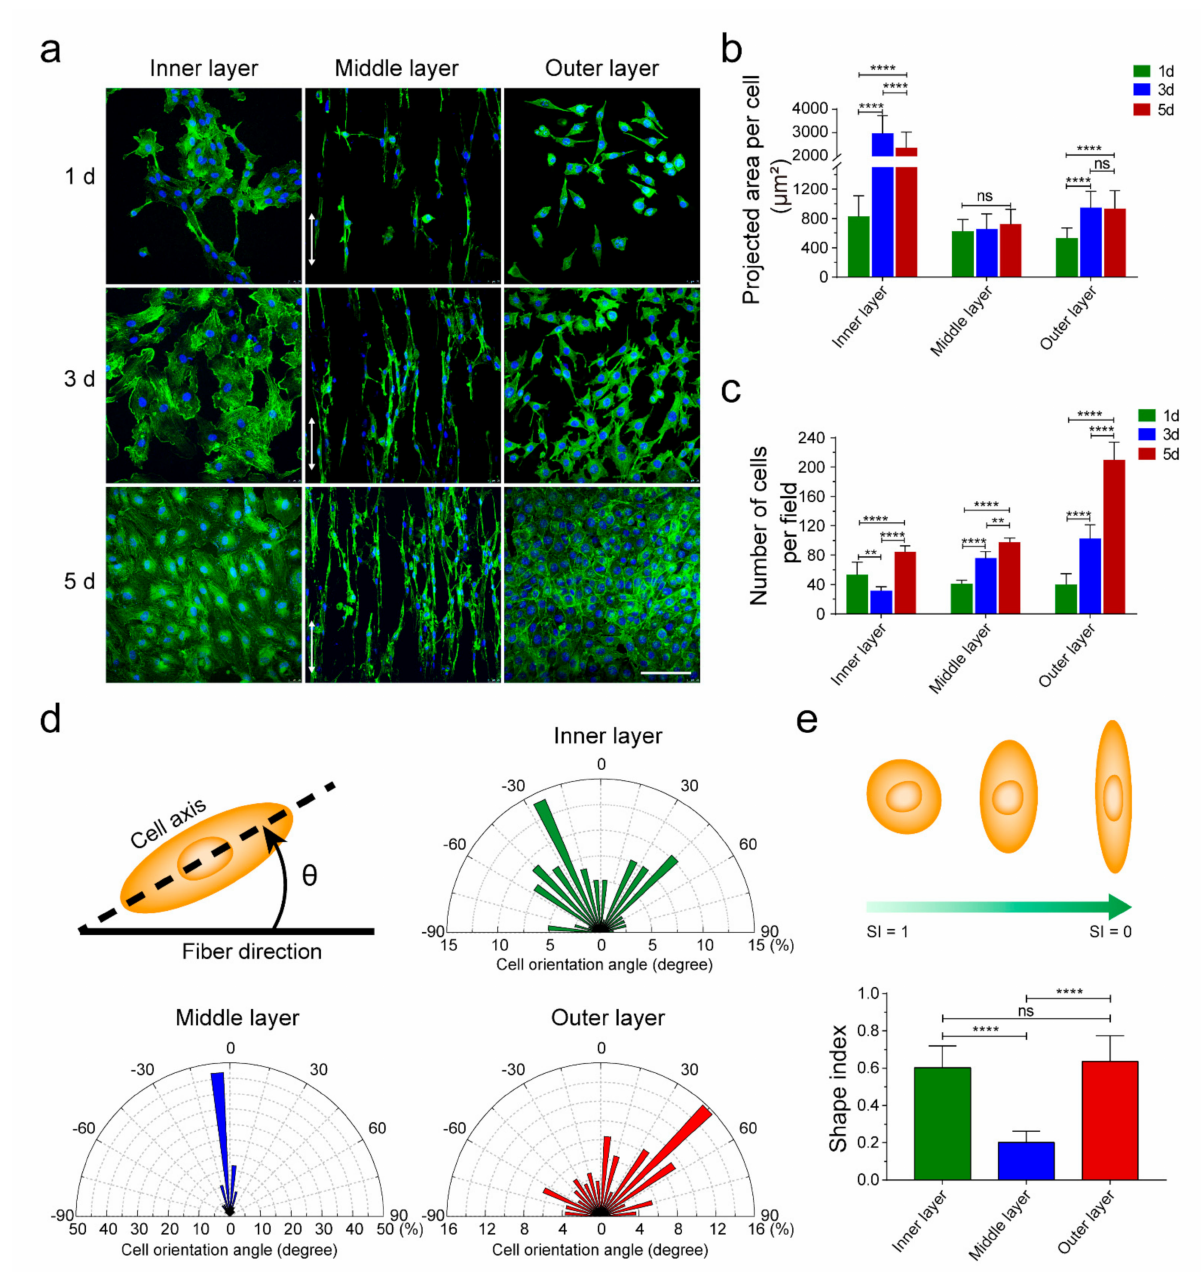
Figure 4. Guiding effects of the topological structure in each layer on vascular cells. ( a ) Phalloidin- iFluor 488 and DAPI staining showing ECs’, VSMCs’, and fibroblasts’ morphology on the inner, middle, and outer layer. White arrows indicate the fiber direction. ( b , c ) Spreading area and density of vascular cells cultured on different layers at Days 1, 3, and 5. ( d ) Orientation angle analysis of the vascular cells cultured on smooth surface substrates (inner layer) and aligned (middle layer) and randomly (outer layer) distributed fibrous scaffolds, respectively ( n = 80). Schematic showing the orientation angle of cells. ( e ) The statistical analysis of the SI of the vascular cells cultured on smooth surface substrates (inner layer) and aligned (middle layer) and randomly (outer layer) distributed fibrous scaffolds, respectively ( n = 60). Schematic showing changes in cell morphology with decreasing SI. The results are expressed as the mean ± s.d., ** p < 0.01 and **** p < 0.0001. ns, not significant. Scale bars: ( a ) 100 µ